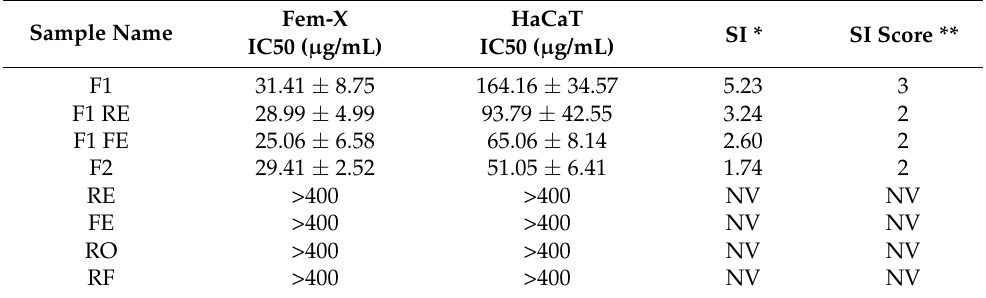
Table 4. In vitro cytotoxic activity (IC50 values), the selectivity indices and the SI scores of the raw materials and the optimized nanoemulsions tested against the tumor cell line (Fem-X) and the non-tumor cell line (HaCaT).